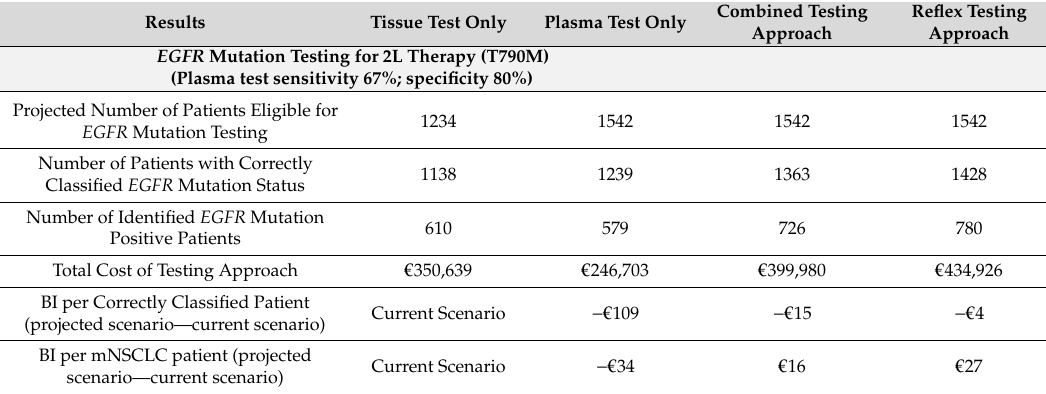
Table 5. Scenario analysis: the results in the 2L setting with lower plasma test performance (sensitivity 67%, specificity 80%). Results Tissue Test Only Plasma Test